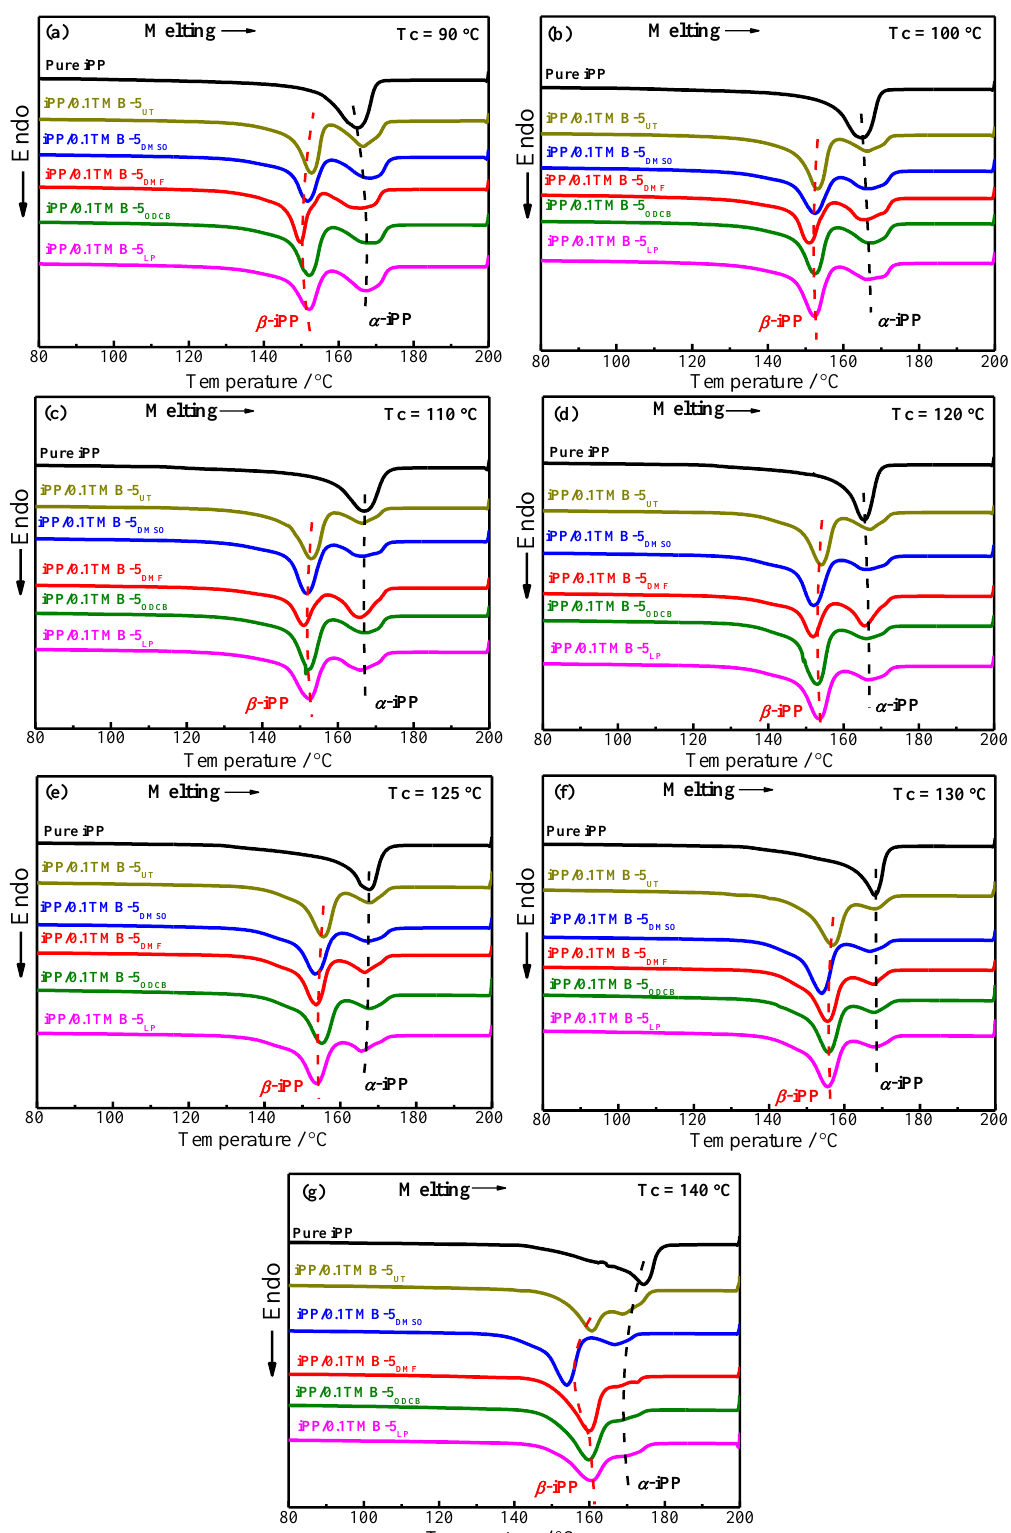
Figure 4. Effects of different solvent-treated TMB-5 NAs on the melting behaviors of iPP and iPP/TMB-5. All the iPP and iPP/TMB-5 specimens were already statically crystallized at each individual crystallization temperatures: ( a ) T c = 90 ̊ C, ( b ) T c = 100 ̊ C, ( c ) T c = 110 ̊ C, ( d ) T c = 120 ̊ C, ( e ) T c = 125 ̊ C, ( f ) T c = 130 ̊ C, ( g ) T c = 140 ̊ C, the NA content is 0.1 wt%, the heating rate is 10 ℃ /min. Notably, there is a difference in melting temperatures of α -crystal and β -crystal be- tween pure iPP and the five different iPP/TMB-5 specimens. The peak melting tempera- ture of α -crystal (T mp, α ) and β -crystal (T mp, β ) are shown in Figure 5. The horizontal axis numbers 0~5 in Figure 5 represent pure iPP, iPP/0.1TMB-5 UT , iPP/0.1TMB-5 DMSO ,